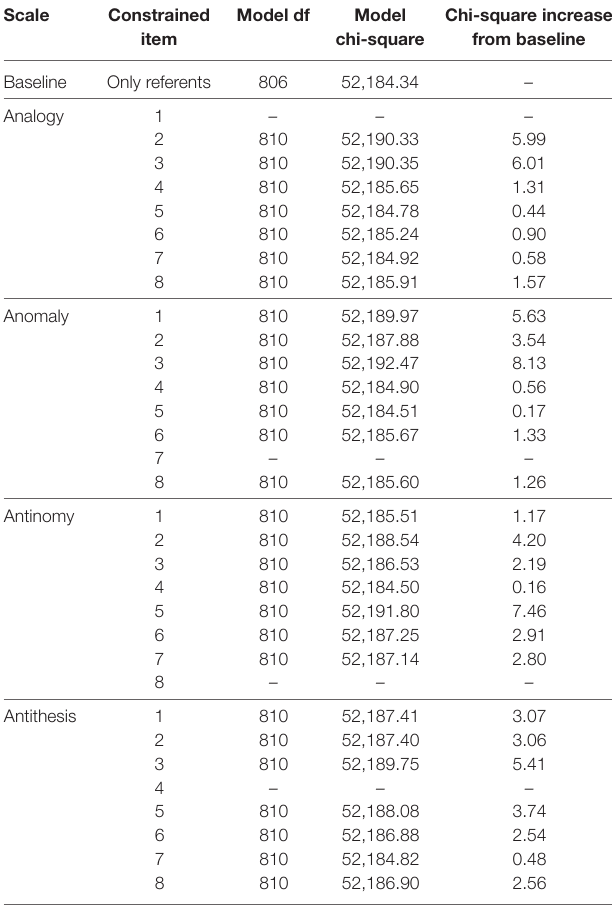
Referents for this analysis were Analogy 1, Anomaly 7, Antinomy 8, and Antithesis 4.